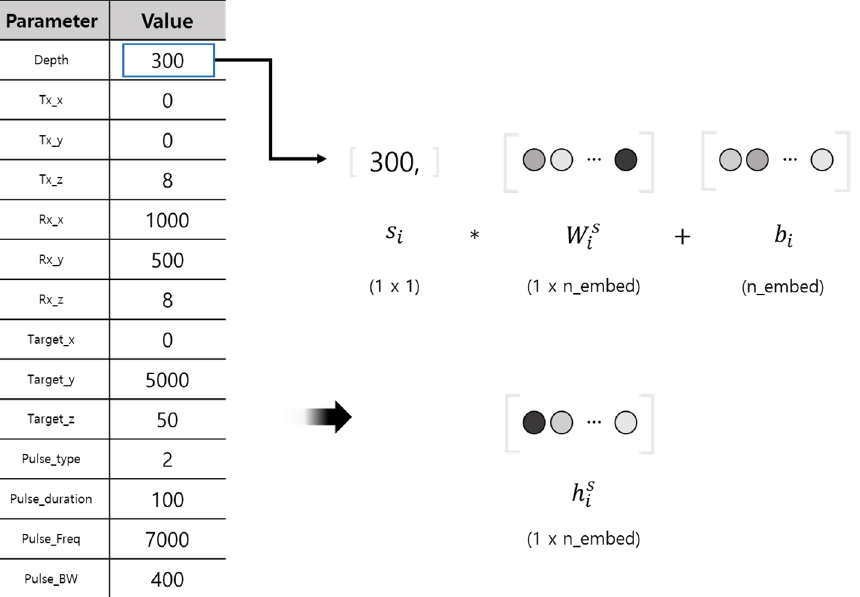
Figure 7. Sonar parameter embedding layer.